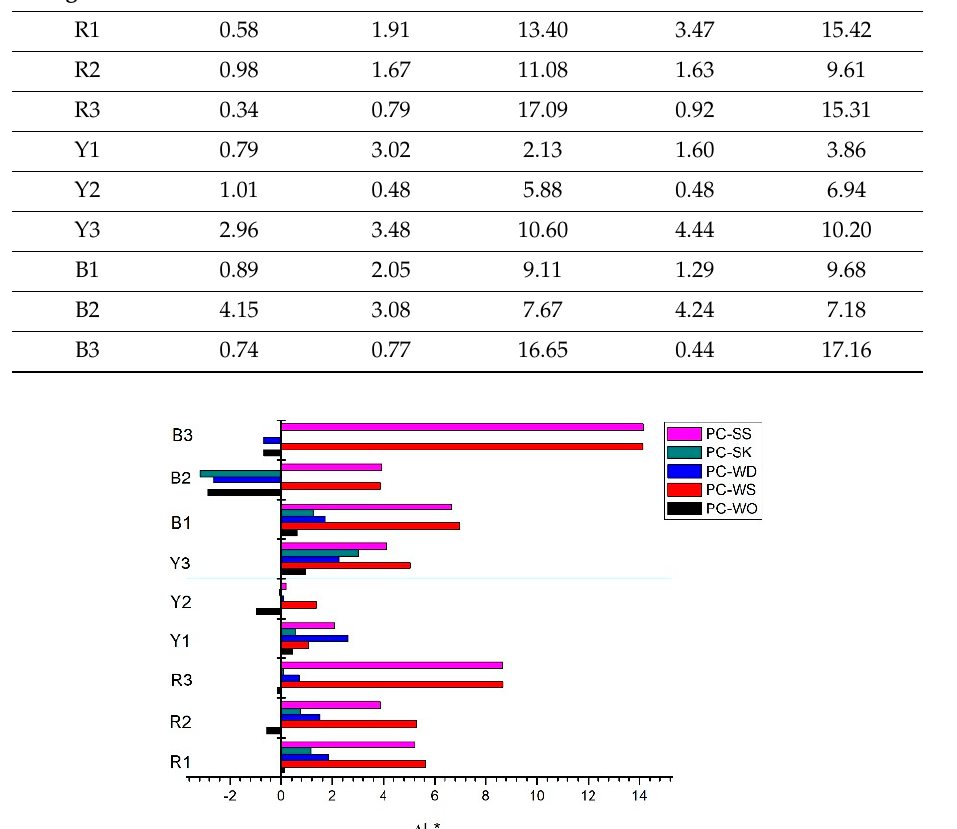
Figure 6. Δ a* calculated using PC adjustment as the target and the other procedures as samples. Figure 7. Δ b* calculated using PC adjustment as the target and the other procedures as samples.